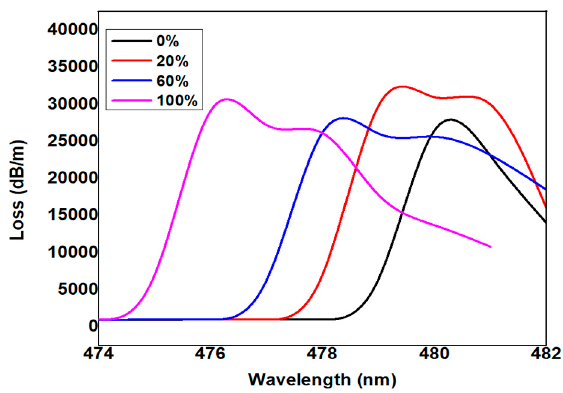
Figure 1. The cross-sectional view of the bimetallic D-shaped optical fiber at the coupling point of the metallic and core modes: ( a ) simulation model and ( b ) the dimensions of the D-shaped optical fiber from microscopy images.